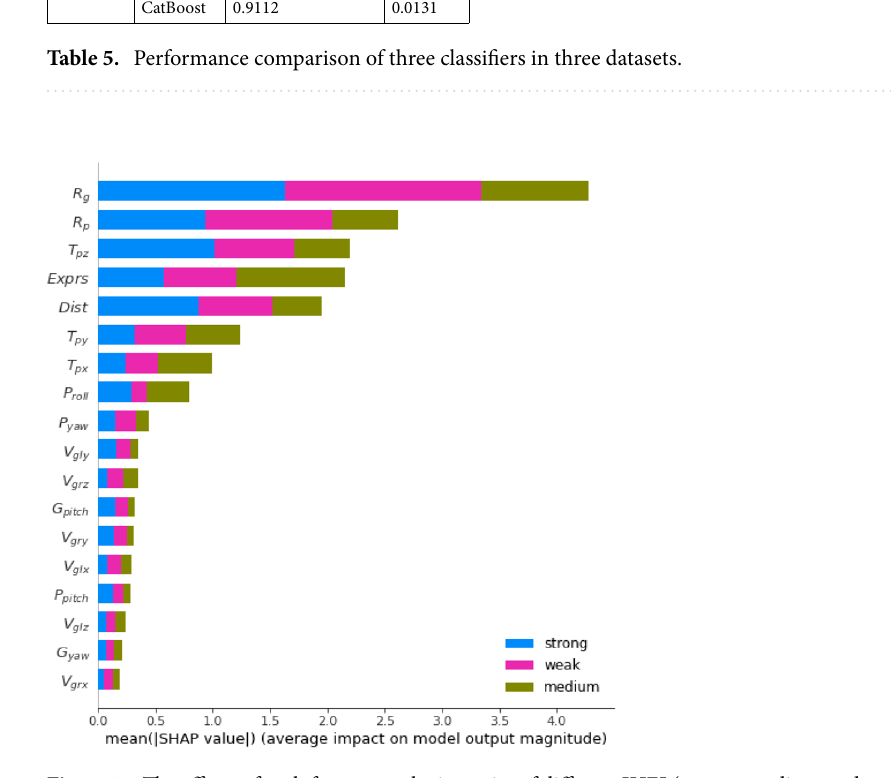
Figure 7. The effects of each feature on the intensity of different IHEI (strong, medium and weak) are obtained by the SHAP analysis. The importance of each feature is ranked in descending